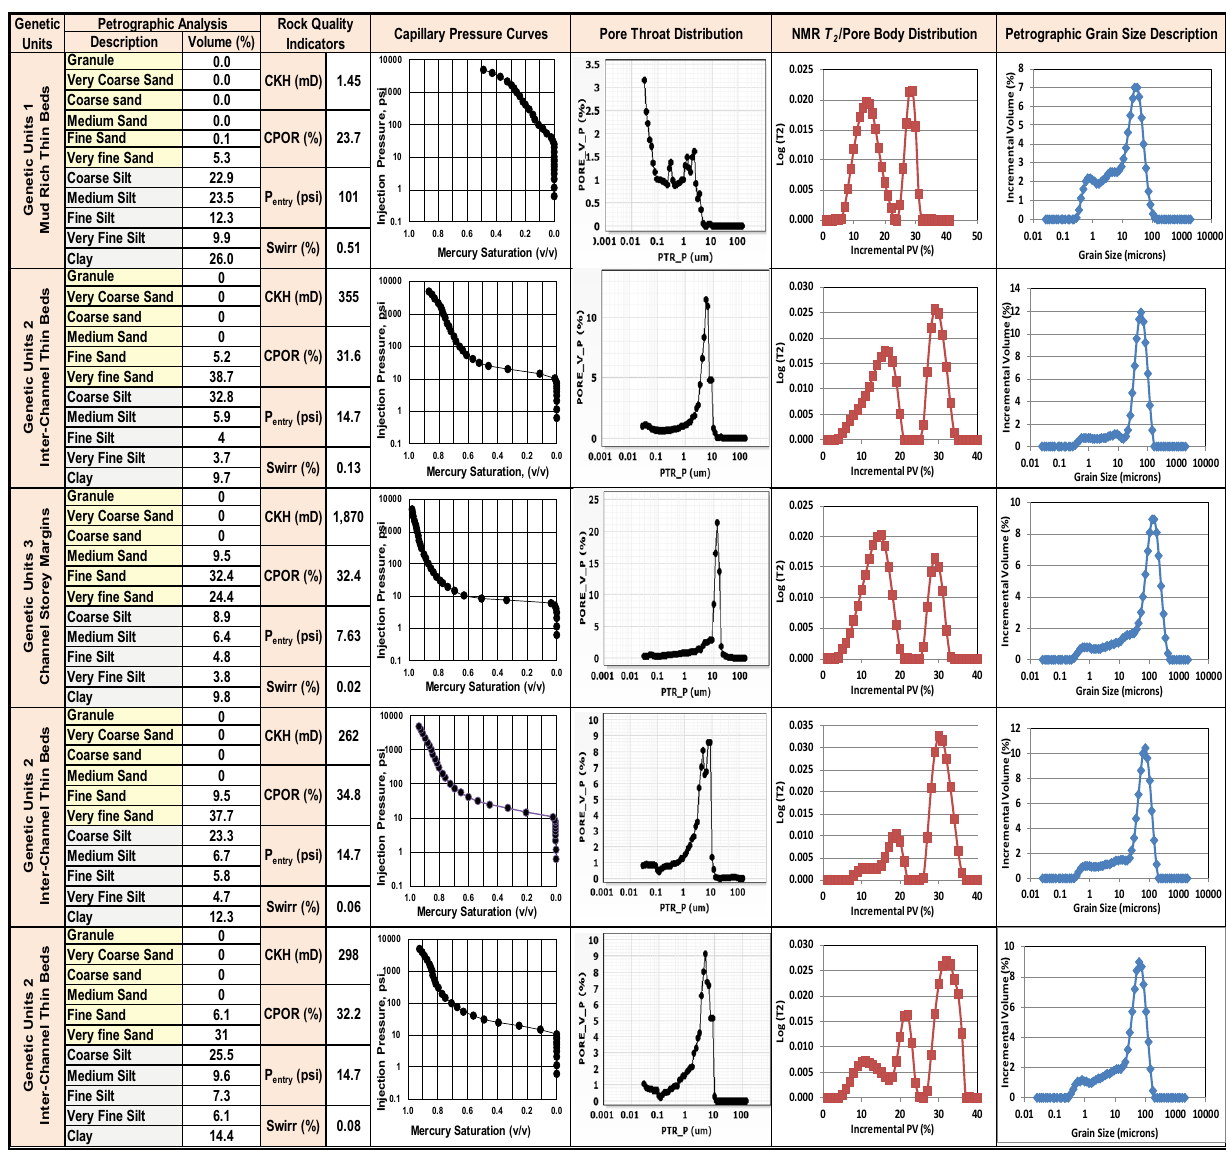
Fig. 11 Sample 1–5 employed for the study. This present petro- graphic grain analysis, NMR T 2 distribution and MICP distribution demonstrating various rock quality indicators; relationship between